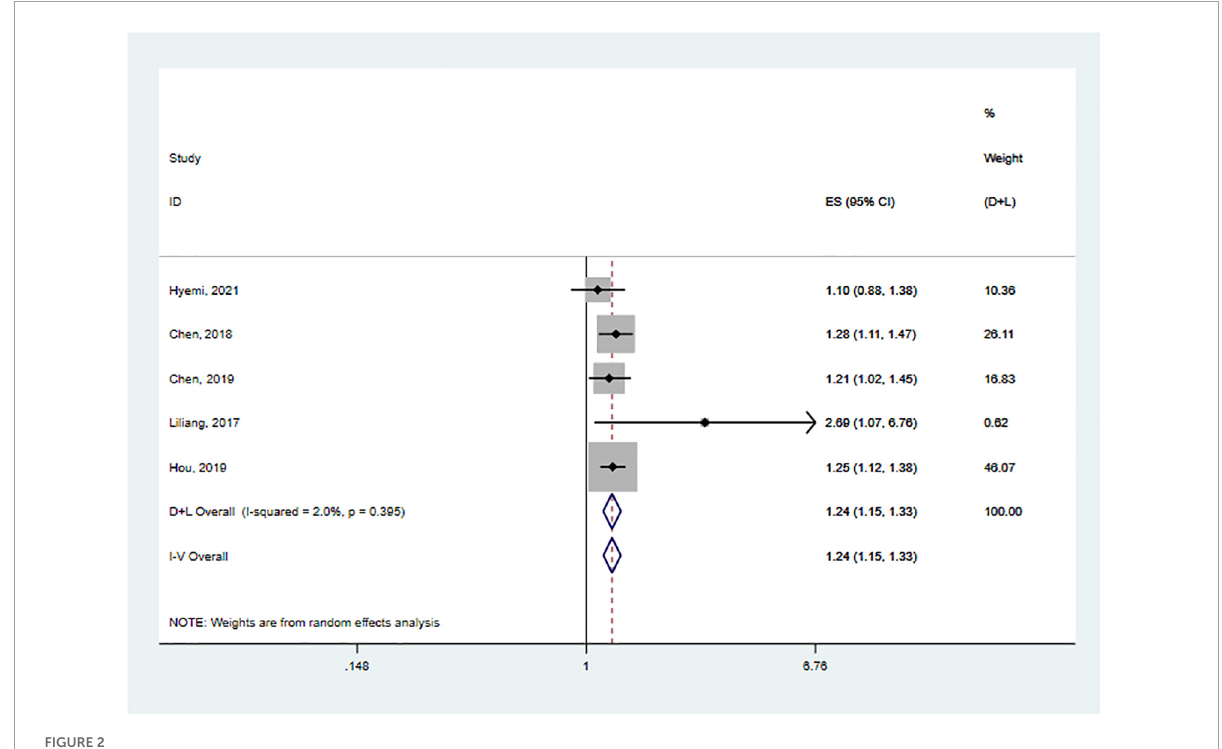
FIGURE2 Forest plot of the association between SS and risks of dementia.